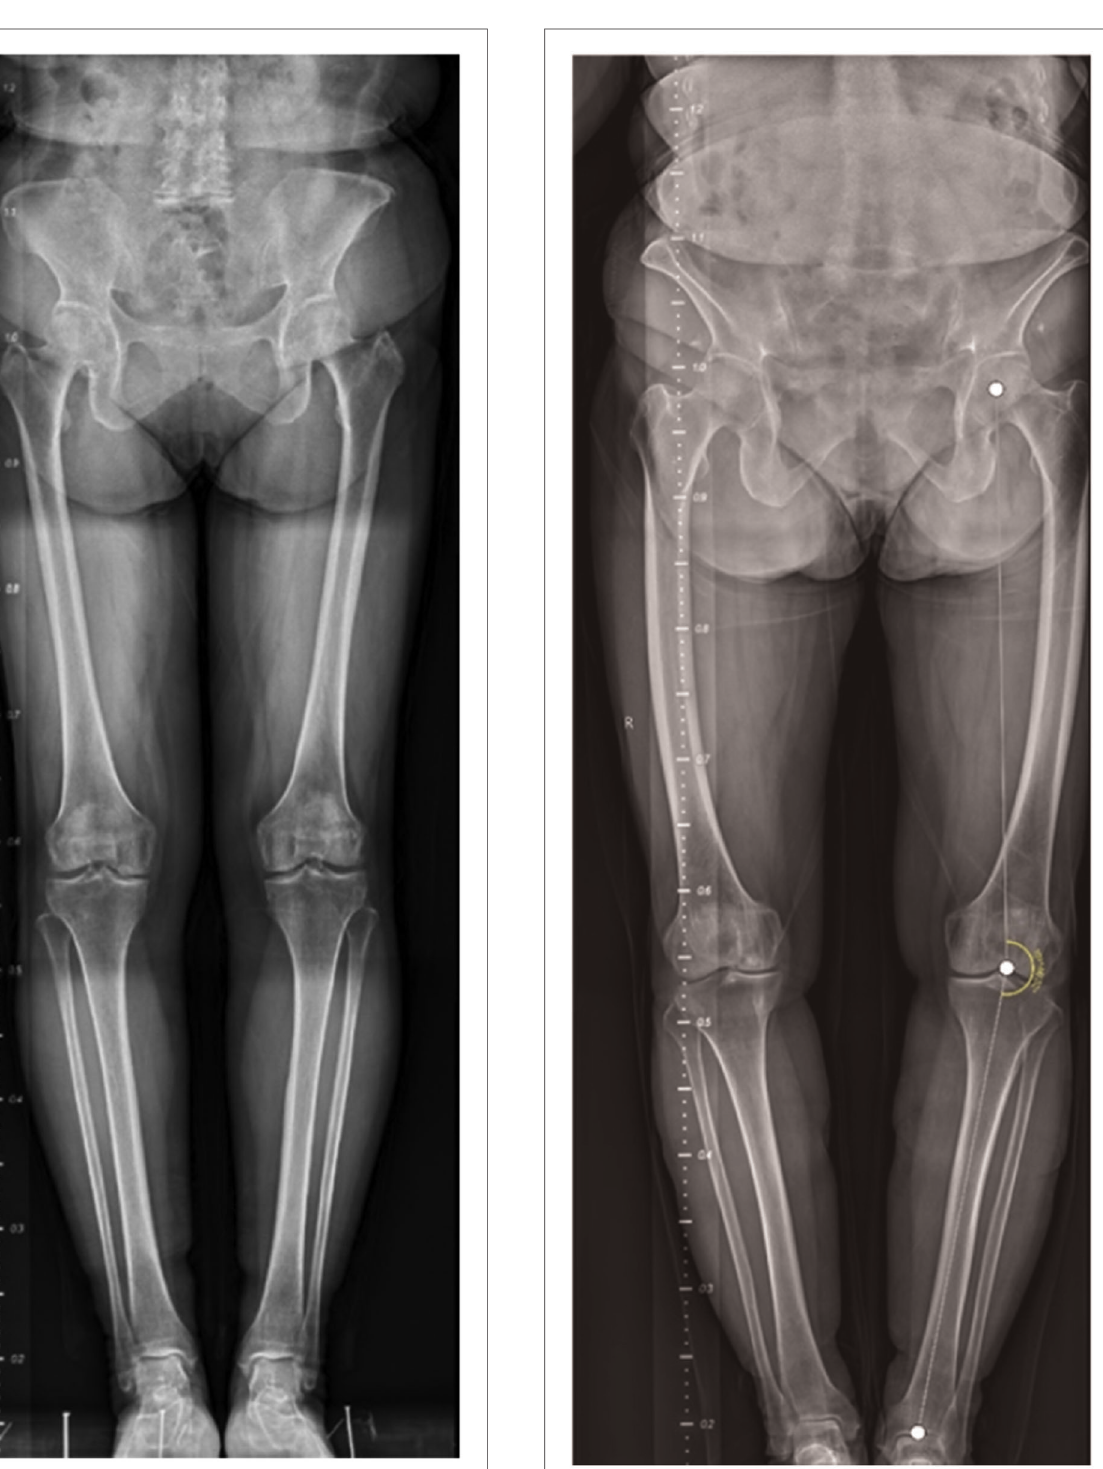
FIGURE 4 HKA angle calculated manually using angle meter. A mid-femur- head point is estimated, a mid-knee joint point and a mid-ankle joint point were estimated to get the HKA